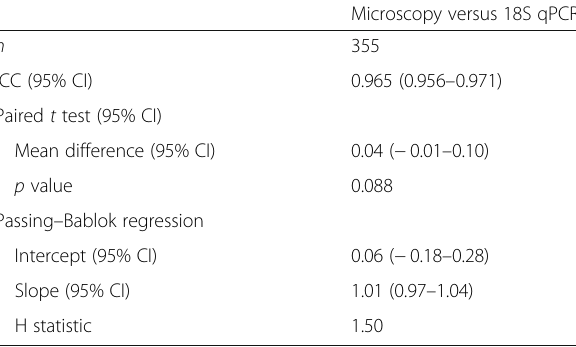
Table 2 Agreement statistics for log 10 parasitemia/mL by